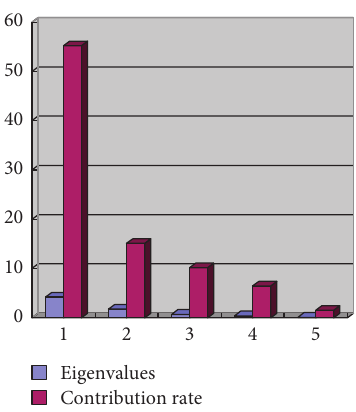
Figure 4: Index processing results of elite teaching optimization